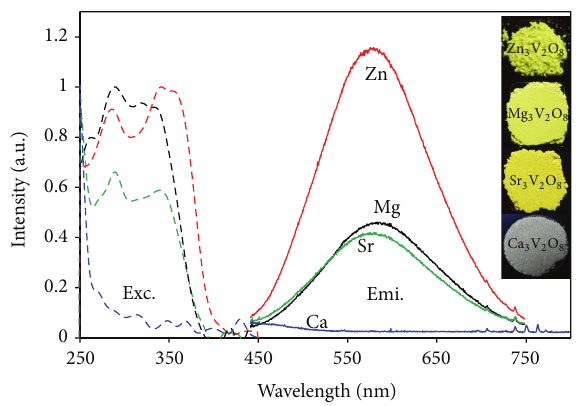
Figure 2: PLE (dotted lines) and PL (solid lines) spectra of M 3 V 2 O 8 (M: Zn, Mg, Ca, and Sr). Inset shows the digital micrograph of corresponding phosphors in black light